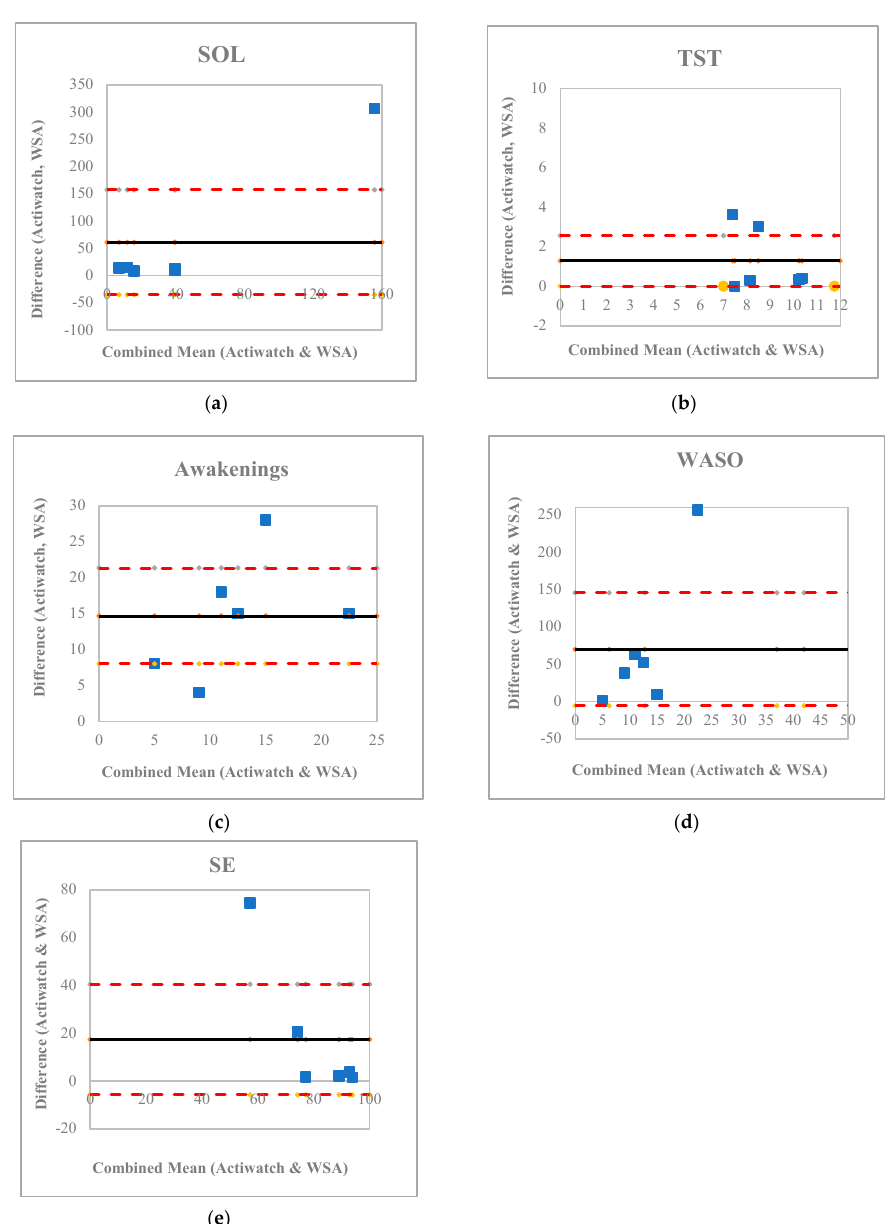
Figure 1. Sleep activity for one participant. ( a ) Philips Actiwatch: Blue shaded region represents time asleep; black bar graph indicates movement and activity overnight; and red lines indicate awake periods. ( b ) WSA: Blue and black regions represent sleep and deep sleep periods respectively; grey regions represent awake periods.